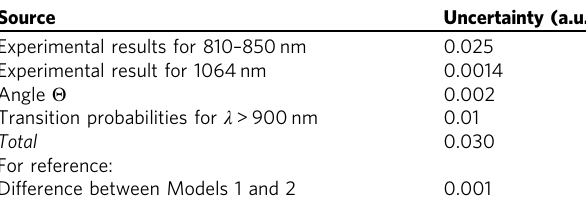
Table 2 Uncertainty budget for the differential scalar polarizability. All sources of uncertainty that contribute